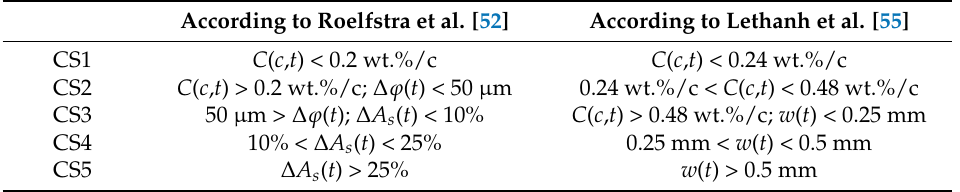
Table 7. Relationship between condition states and performance indicators of carbonation induced corrosion given in